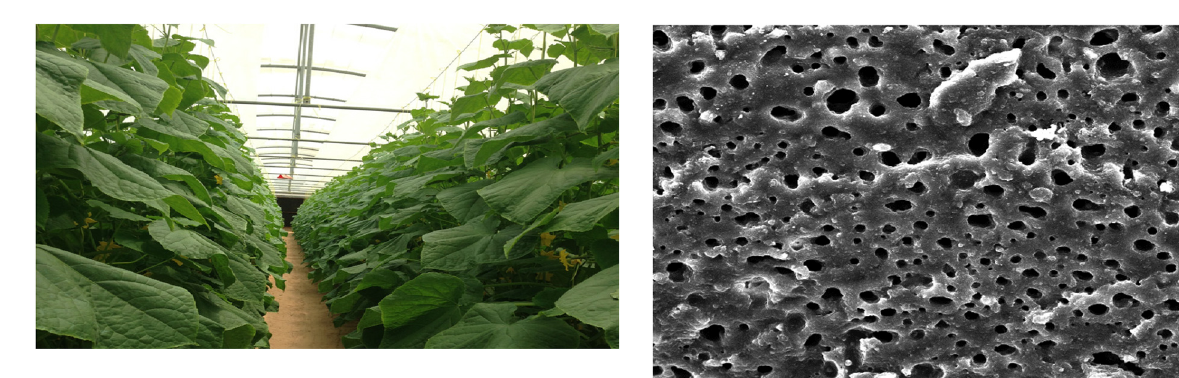
Figure 9: Polycarbonate covering material.